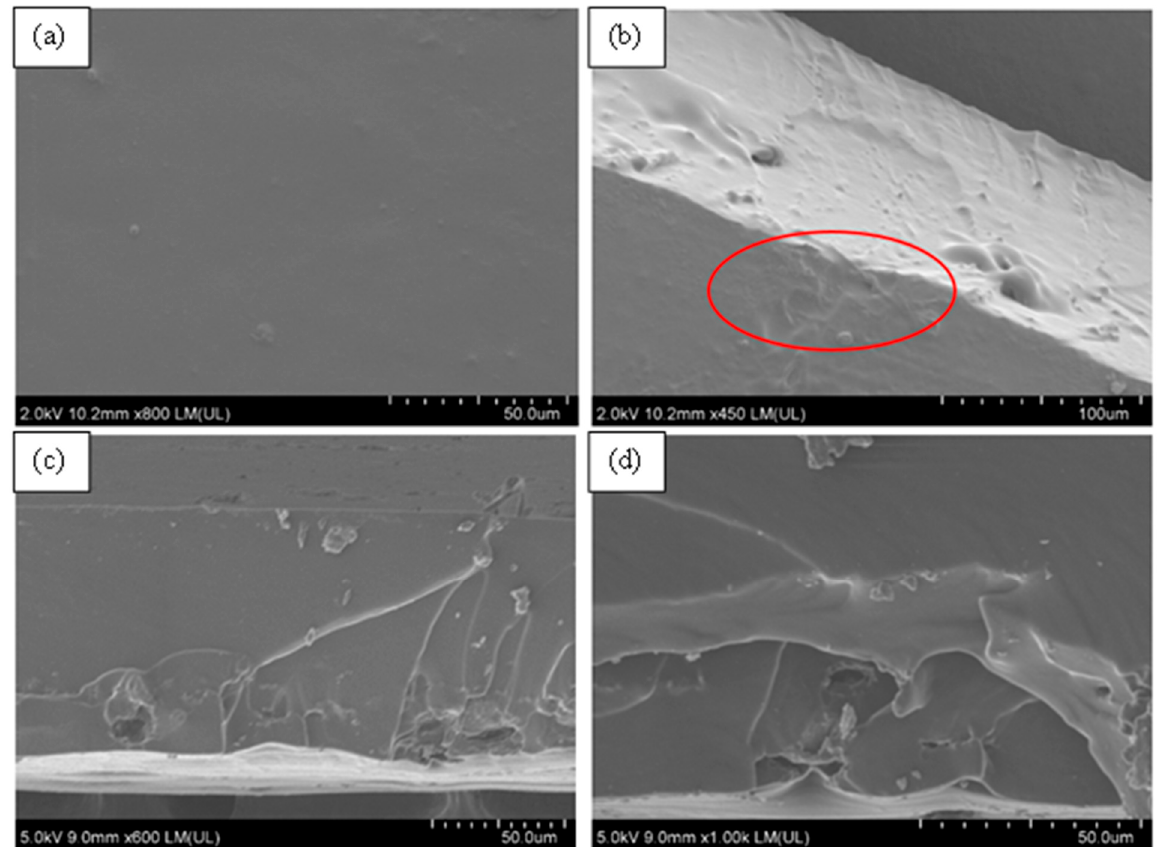
Figure 11. FE-SEM micrographs of neat PU. ( a ) Surface morphology at × 600, ( b ) side-view morphology at × 450, ( c ) tensile fracture surface × 600, and ( d ) tensile fracture surface at × 1000.